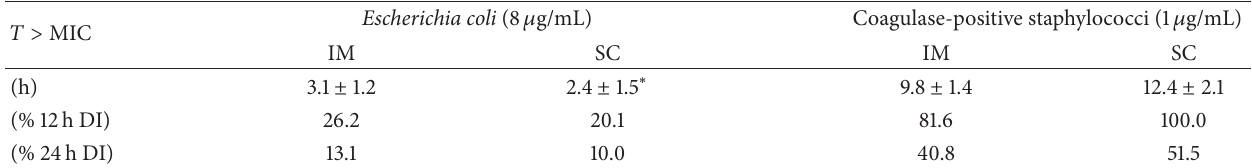
Table4:TimeaboveMIC 90 ( 𝑇 > MIC)calculatedforlong-actingcephalexinfollowinganintramuscular(IM)andsubcutaneous(SC)8 mg/kg injection to 6 llamas. Results are expressed in hours (h) and dosing interval (DI)